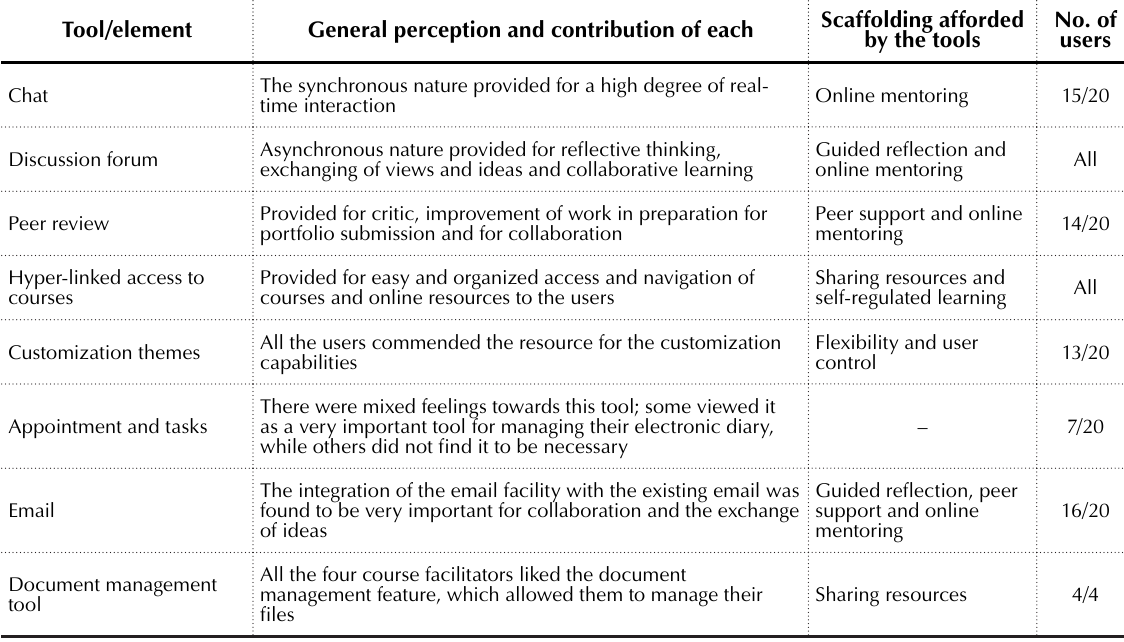
Table 5. Tools and elements that users appreciated, and their contribution towards learning